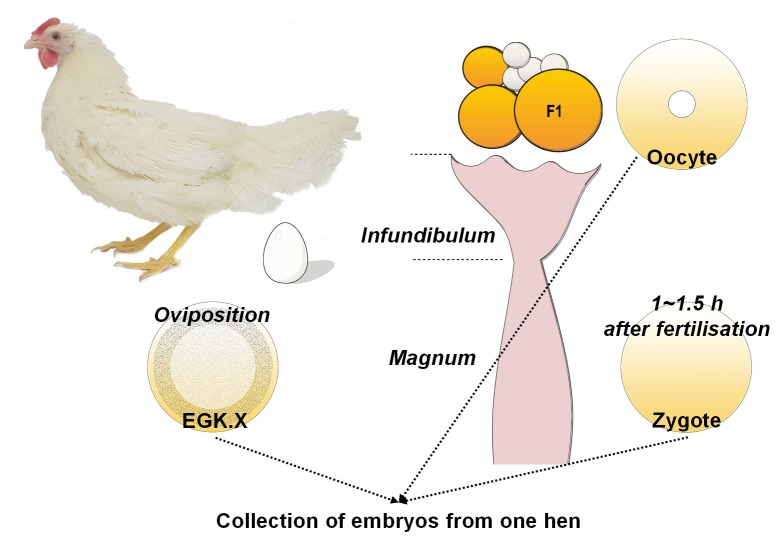
Schematic diagram of single oocyte, zygote and EGK.X embryo acquisition from one hen on the same day.On the day of embryo acquisition, an EGK.X blastoderm was acquired at oviposition and the time was recorded. Approximately 1–1.5 hr after fertilisation according to the recorded egg-laying times, a pre-ovulatory F1 oocyte in the ovary and a zygote in the magnum were simultaneously collected.